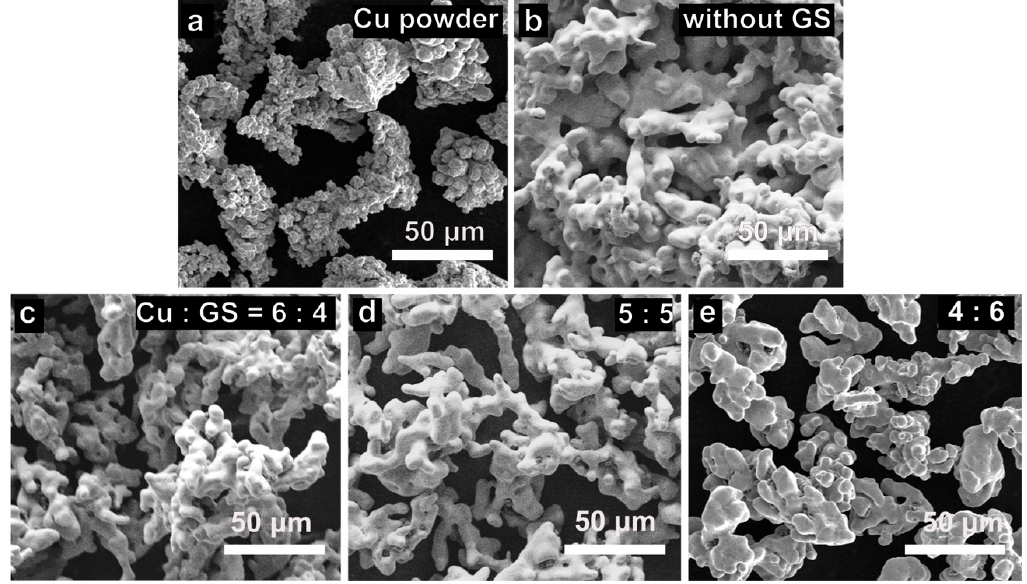
Figure 2. Scanning electron microscopy (SEM) images of ( a ) Cu powder and ( b ) after thermal treatment without the use of removal spacers. Gr/Cu microparticles grown with different mixing ratios of Cu and GS: ( c ) 6:4; ( d ) 5:5; ( e ) 4:6.